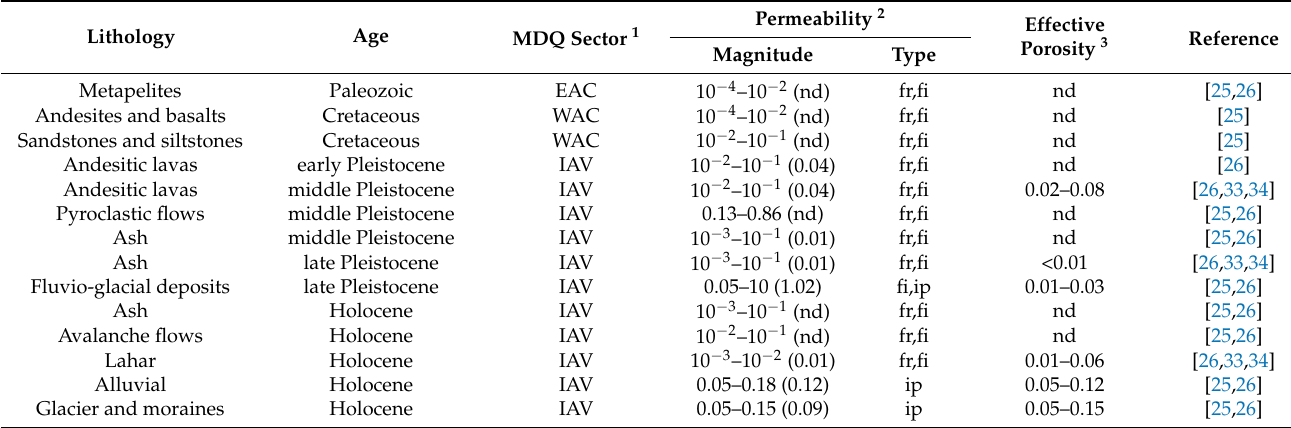
Table 1. Compiled information regarding the permeability and effective porosity of representative geological formations in the